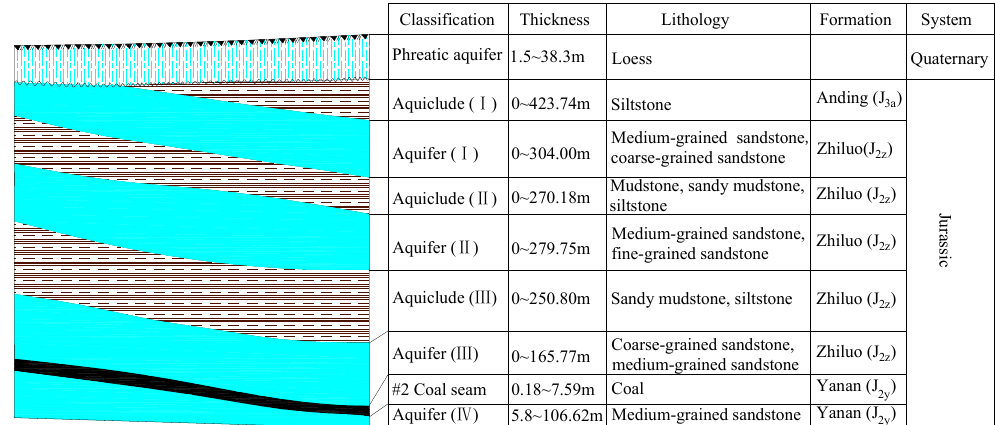
Figure 2. Main aquifers and aquicludes.